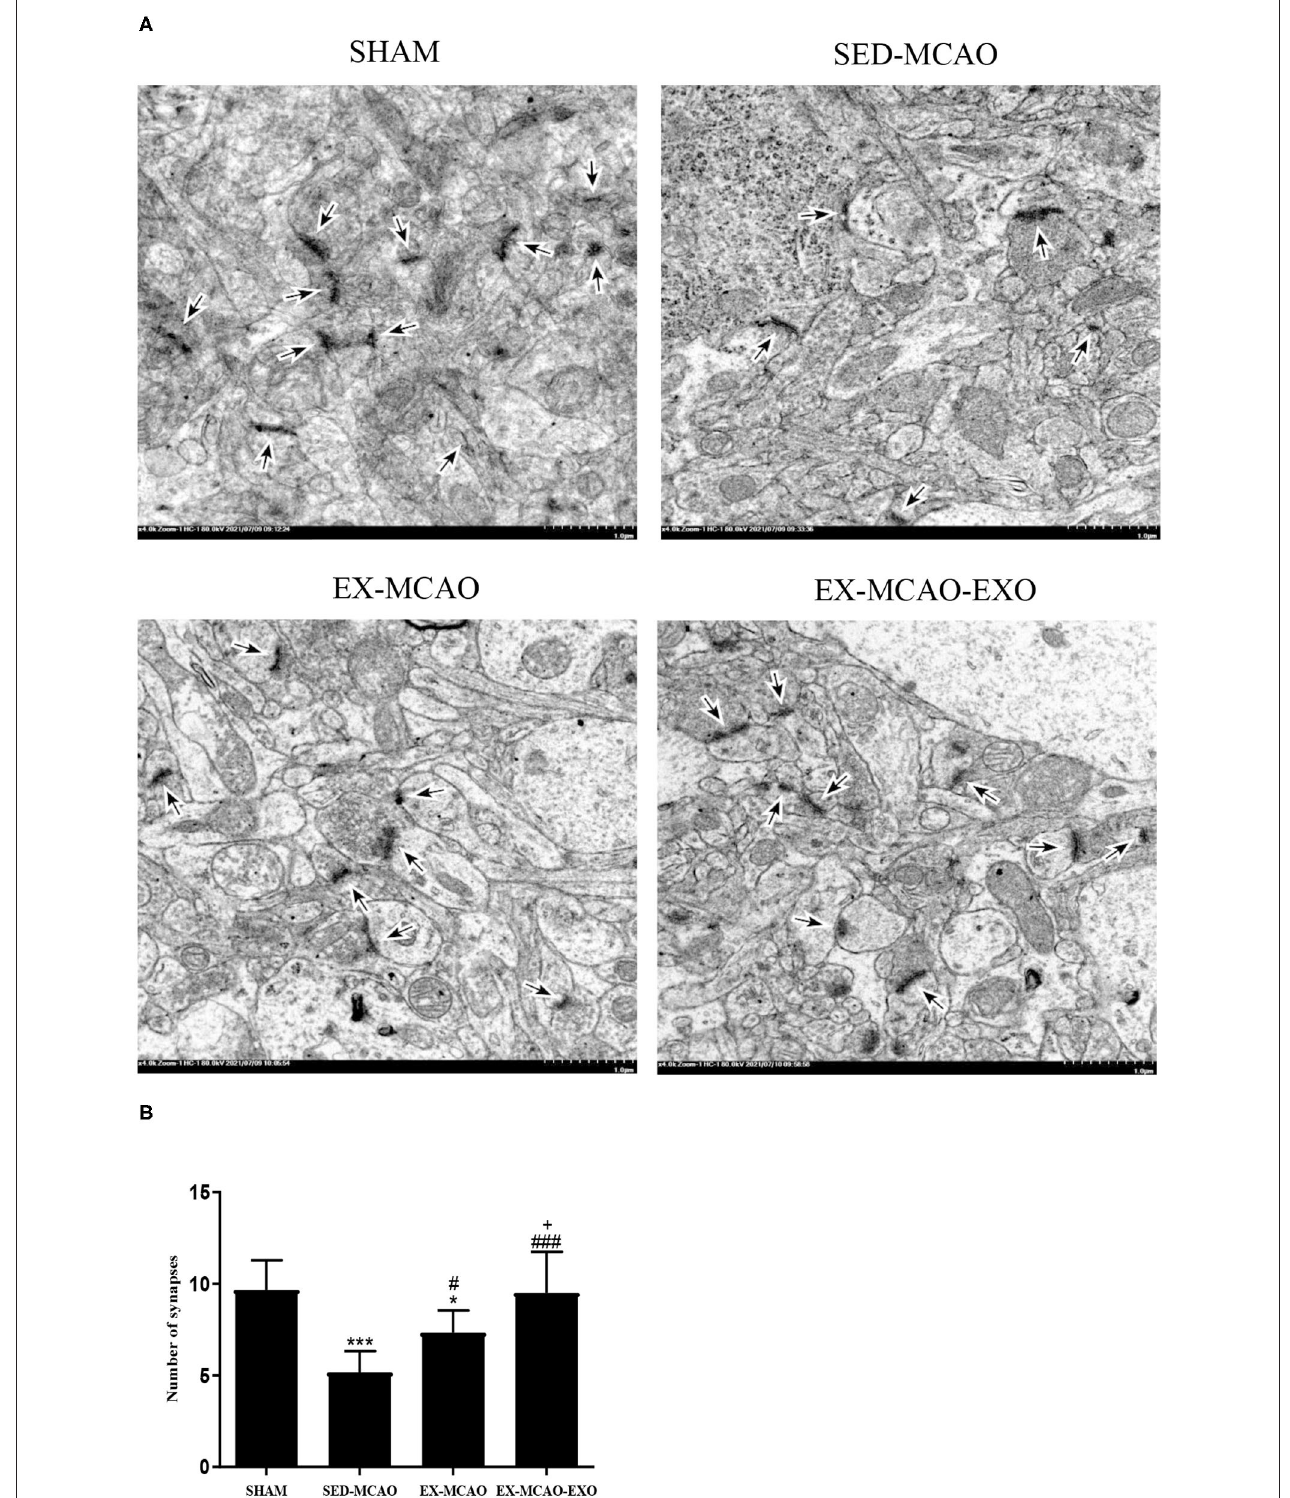
FIGURE 4 | Synapses were detected using transmission electron microscopy. (A) Representative images of synapses in the four groups. The synapse was observed under an electron microscope at × 4.0k magnification (bar = 1.0 µ m). (B) The number of synapses. * p < 0.05 and *** p < 0.001 compared with the corresponding SHAM group. # p < 0.05 and ### p < 0.001 compared with the corresponding SED-MCAO group. + p < 0.05 compared with the corresponding EX-MCAO group. Means ± standard deviations, n = 3/group.